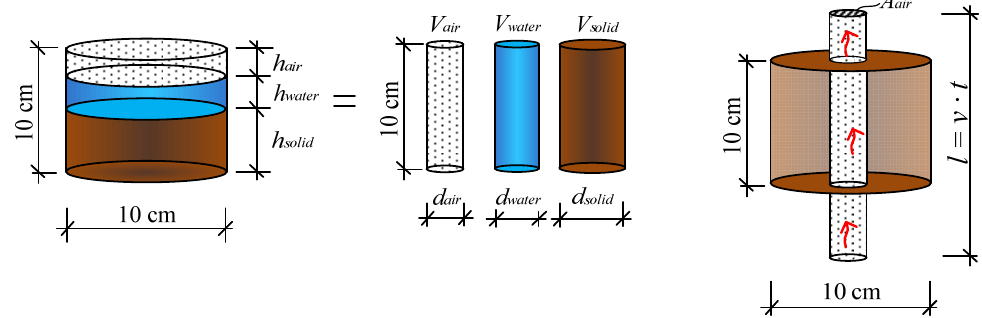
Figure 5. Cumulative cross-section of air voids channel: h air , h water , h solid —volume of air, water and solid particles, V air , V water , V solid —cumulative height of air, water and solids, d air , d water , d solid —diameter of regrouped volumes of air, water and solids, l —length of air